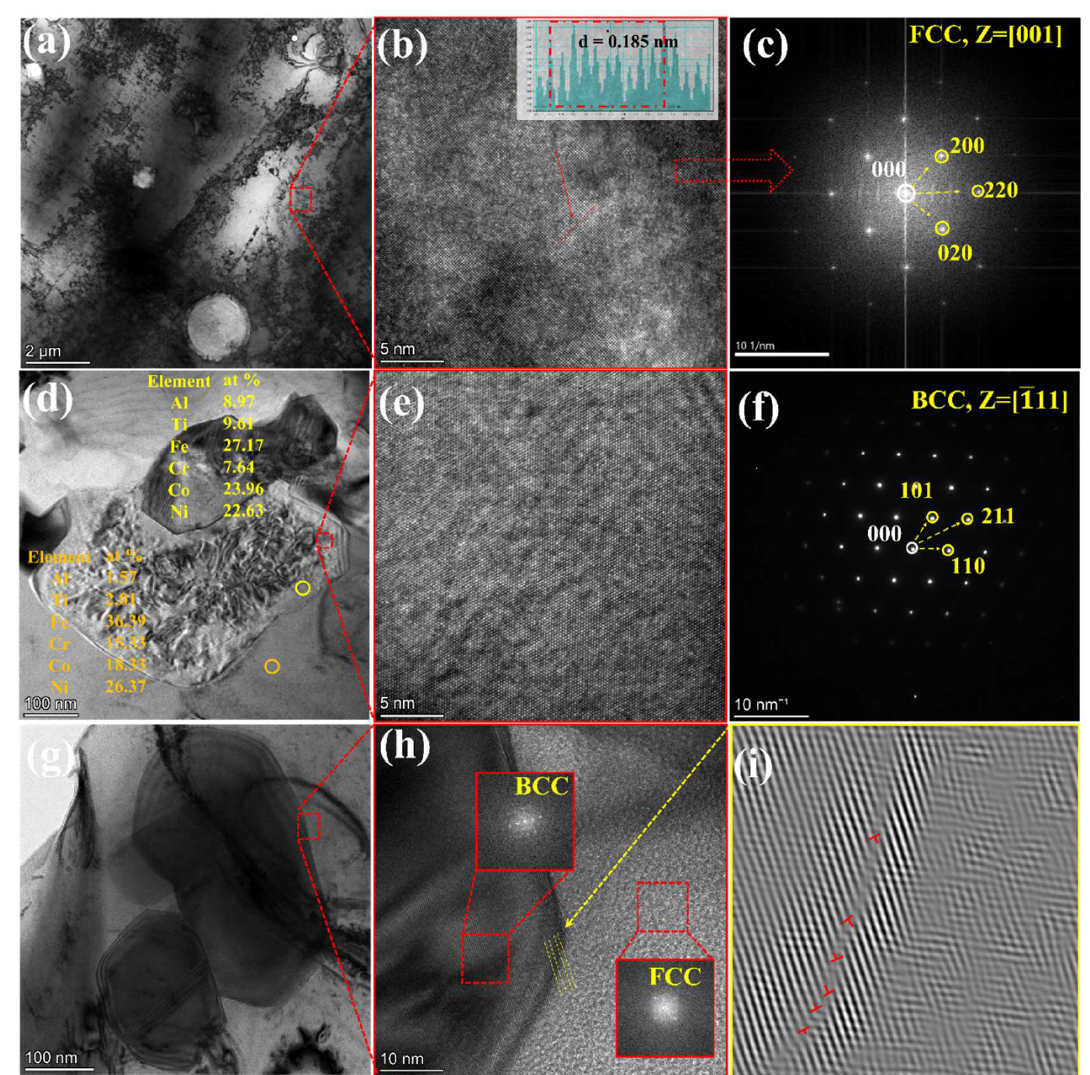
Figure 4. TEM image of the of Al x Ti 1− x ( x = 0, 0.5, 1): ( a ) Bright-field image of Al 1 Ti 0 , ( b ) HRTEM images of matrix, ( c ) SAED patterns corresponding to (a2), ( d ) Bright-field image of Al 0.5 T i0.5 , ( e ) HRTEM images of particle phase from matrix, ( f ) SAED patterns corresponding to ( e ), ( g ) Bright-field image of Al 0 Ti 1 , ( h ) HRTEM image showing the interfaces between the FCC matrix and BCC particles with FFT (Fast Fourier Transform) patterns, ( i ) IFFF (Inverse Fast Fourier Transform) pattern of the interfaces between the FCC matrix and BCC particles.